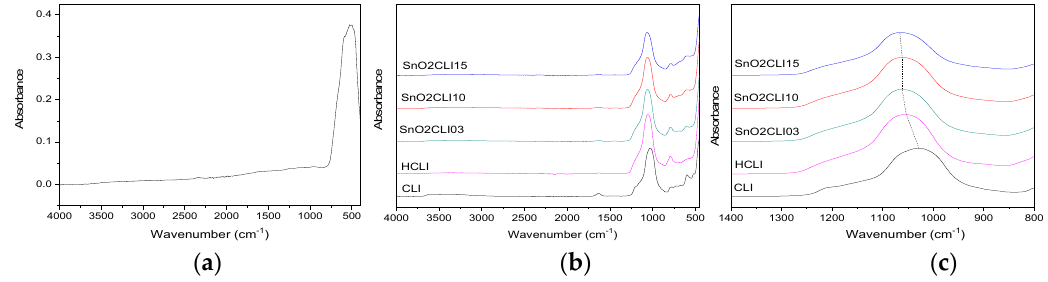
Figure 7. Attenuated total reflection (ATR)-FTIR spectra of ( a ) SnO 2 and ( b ) SnO 2 -containing clinoptilolite. In ( c ) a closer range (1400–800 cm − 1 ) is shown.